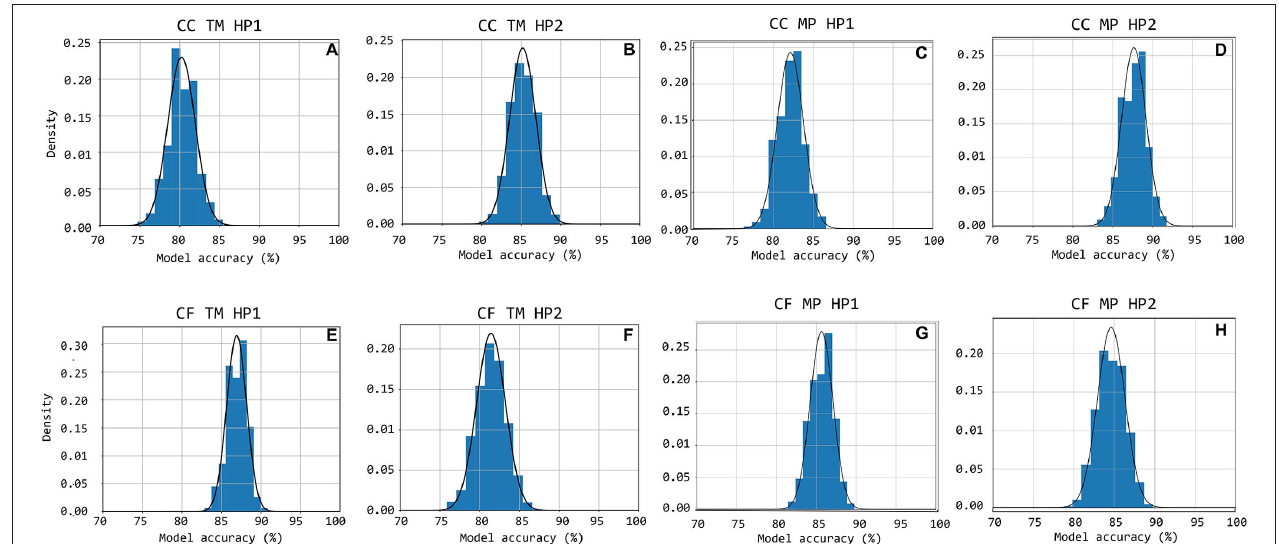
FIGURE 11 | Accuracy distributions for 1,000 random train-test set partitions and subsequent logistic regression models trained. The accuracy distribution is shown cumulatively through bar-charts with the equivalent Gauss-curve plotted on top of it. Subfigures (A–H) show this for CC HP1, CC HP2, CF HP1, and CF HP2 cases, respectively.